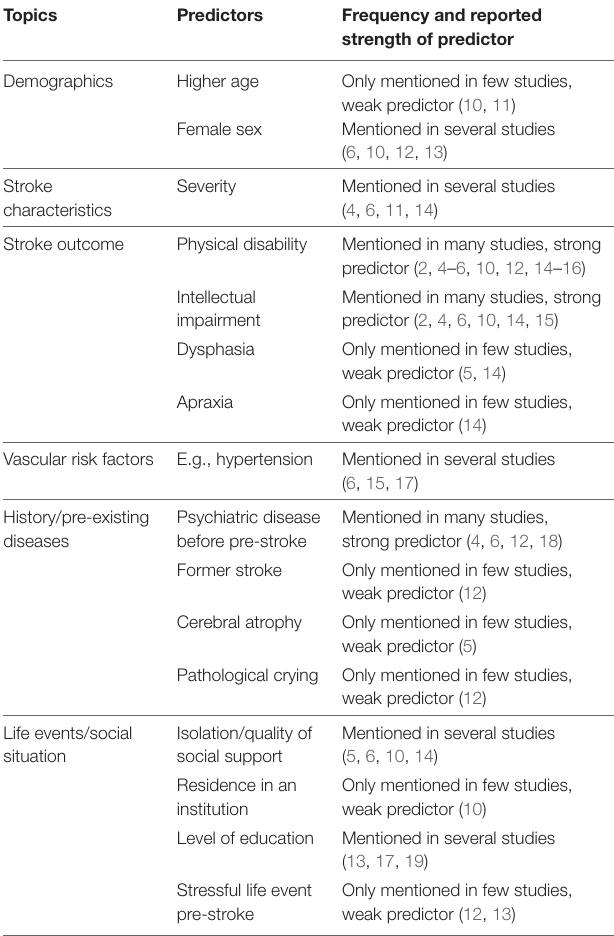
TAbLe 1 | Predictors of post-stroke